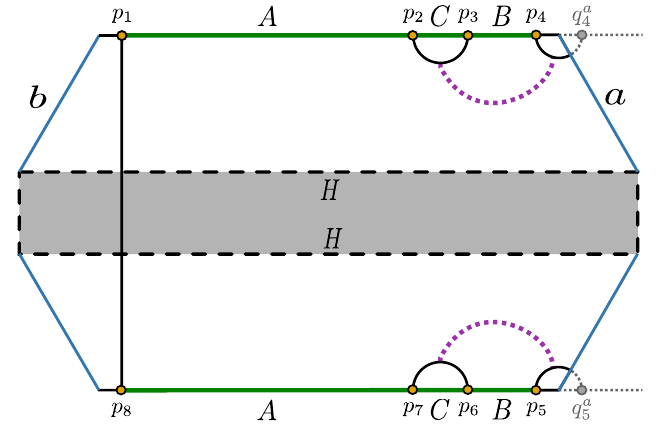
Figure 34 . The endpoints of the intervals A and B and the image points in the two BCFT 2 copies are identified similarly as in figure